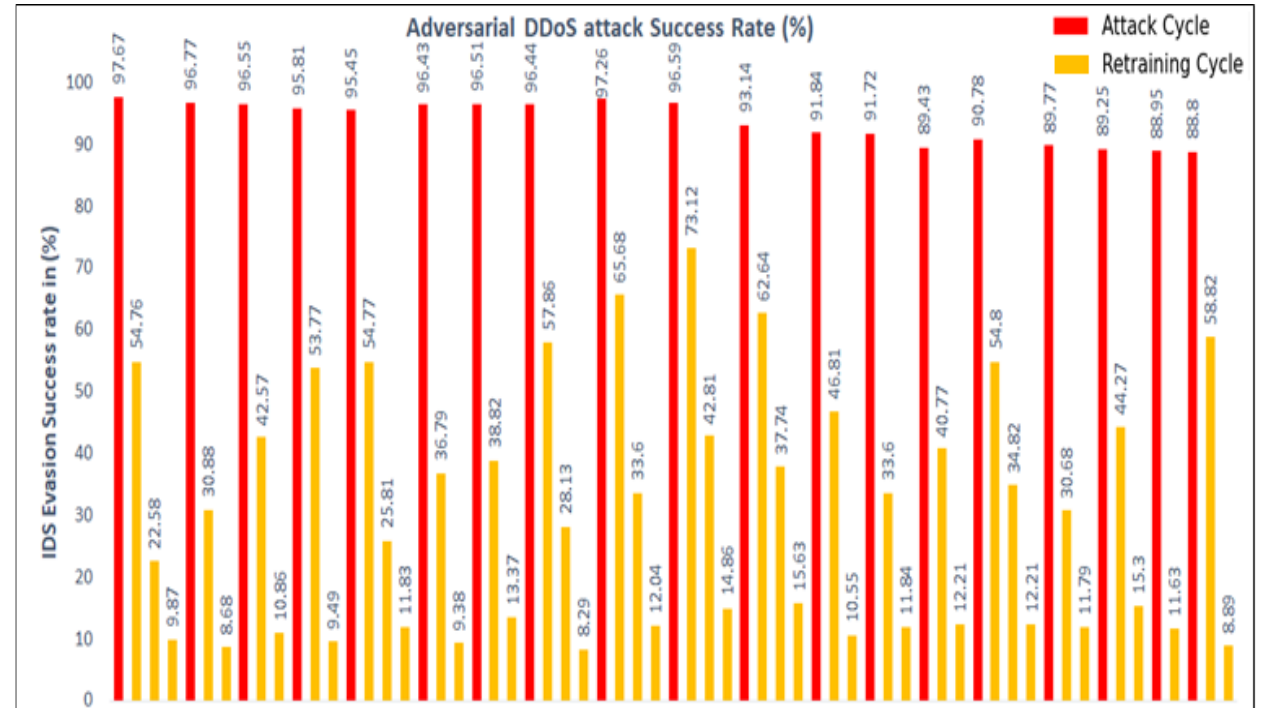
Figure 10. Polymorphic adversarial attacks using the automated feature selection (40 features).